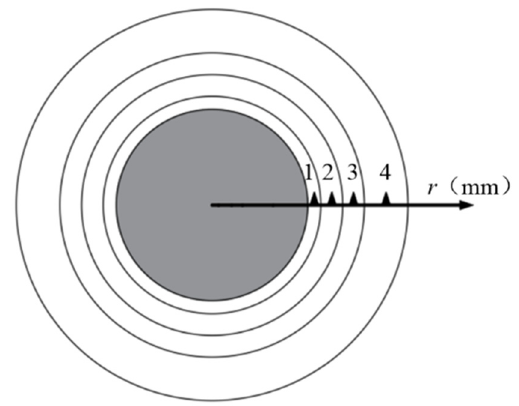
Figure 9. Regional division.